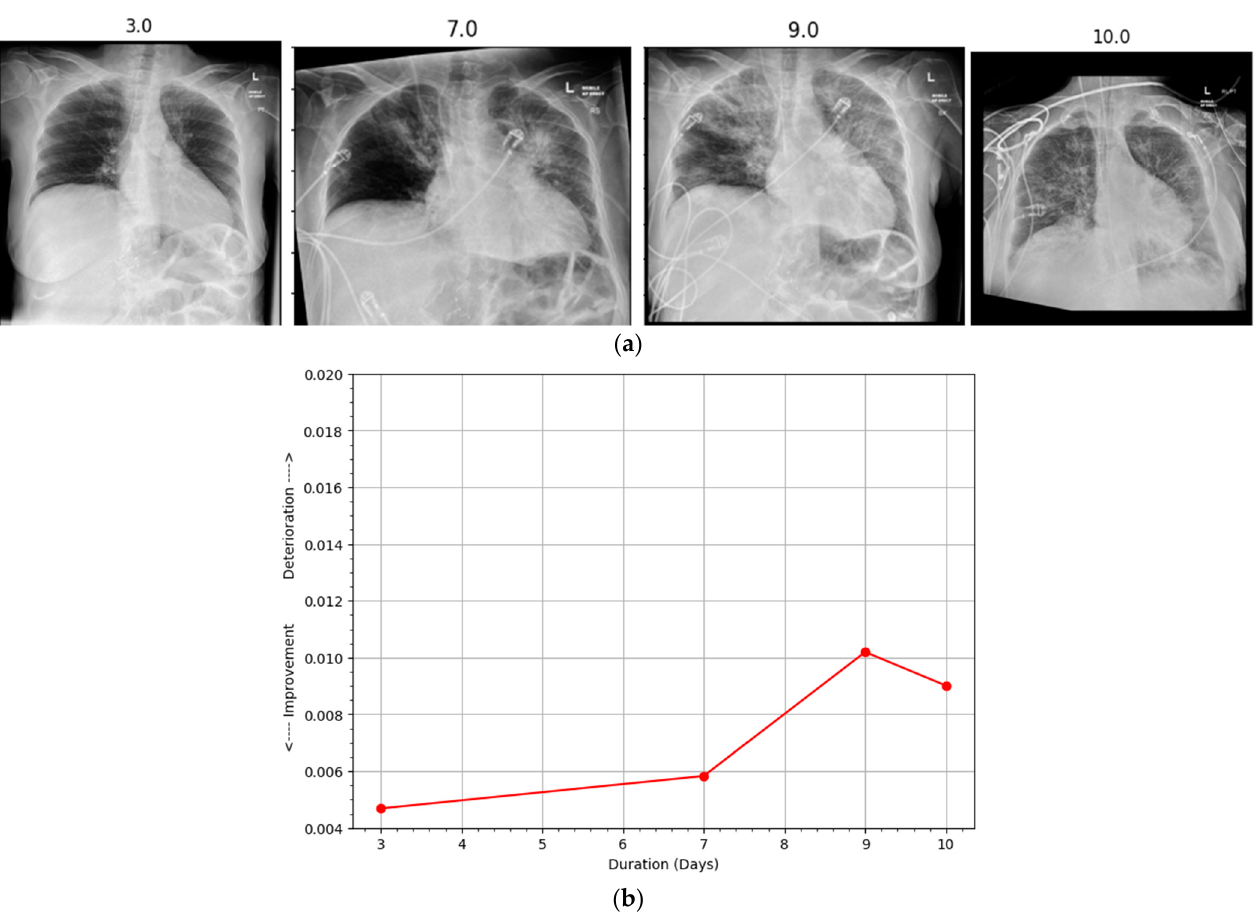
Figure 5. ( a ) Subsequent radiographs belonging to a patient (173) who exhibited deterioration till day 9 but showed improvement on day 10, which is reflected in ( b ) the disease progression profile (red line). The patient was intubated but survived the infection.